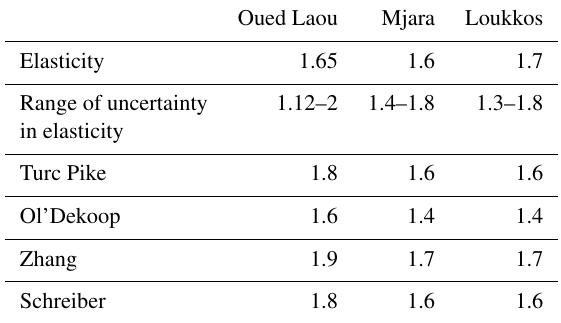
Table 6. Elasticity of the runoff to precipitation estimation and quantification of the uncertainty compared with the analytical for- mulas given in Table